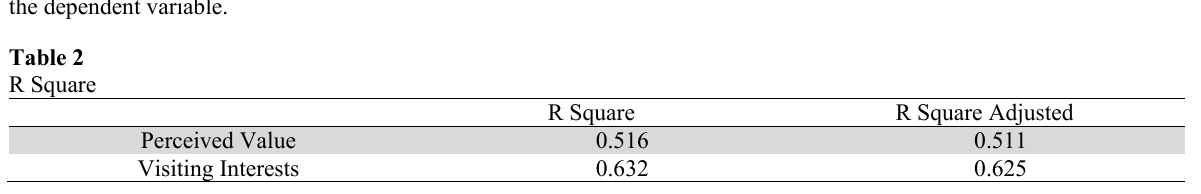
R Square R Square